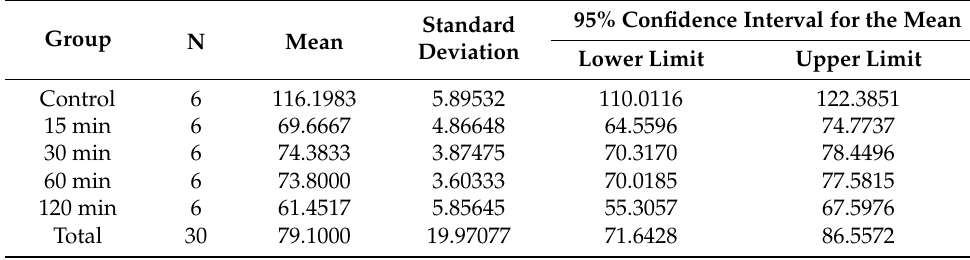
Table 1. Data obtained with the 6 W lamp.